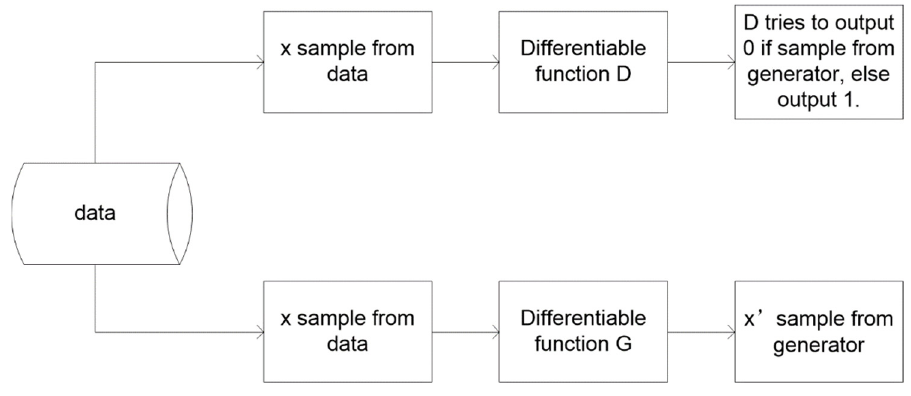
Figure 8. Flow Chart of GAN method.